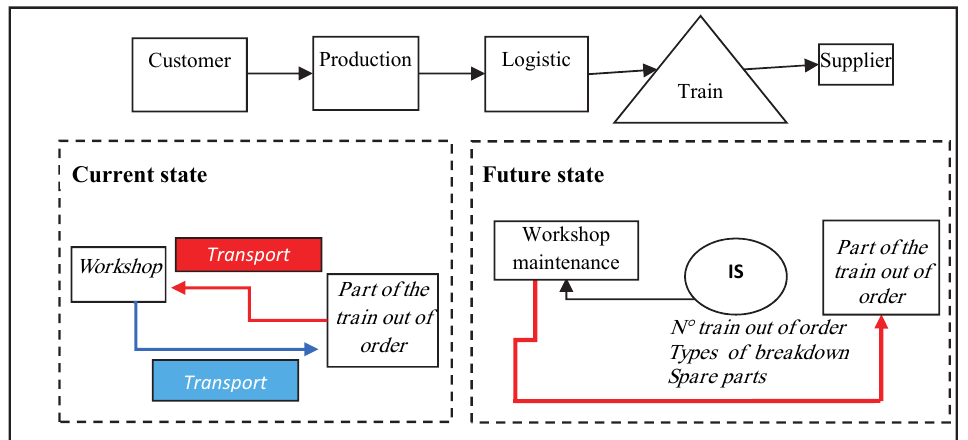
Fig. 3. Reduction of useless